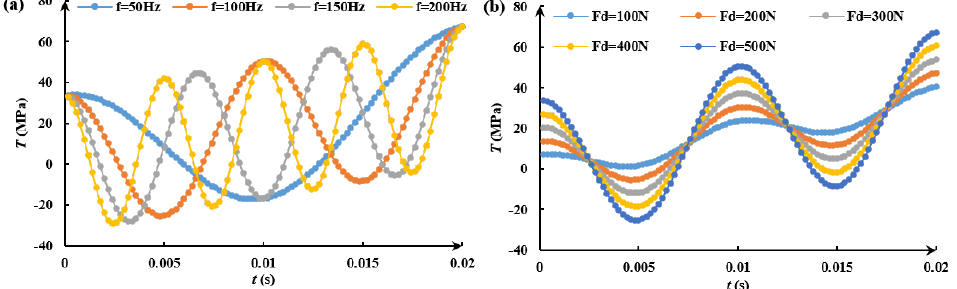
Figure 10. Variation curves of T-stress at crack tip with time under different harmonic dynamic loads: ( a ) different frequencies; ( b ) different amplitudes.